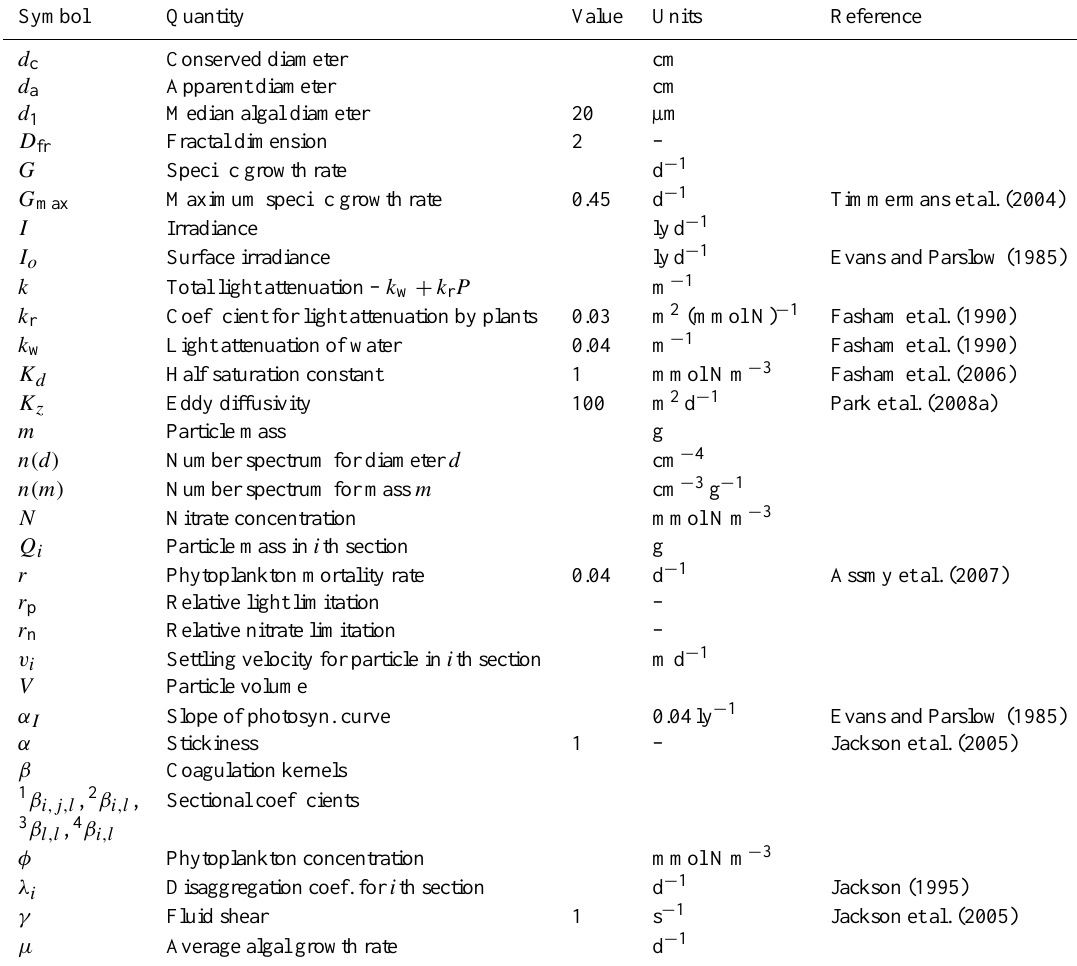
Table 2. Symbols and parameter values used for the model. Conversion constants include the following: carbon to chlorophyll – 50gC:gChl a ; carbon to nitrogen –